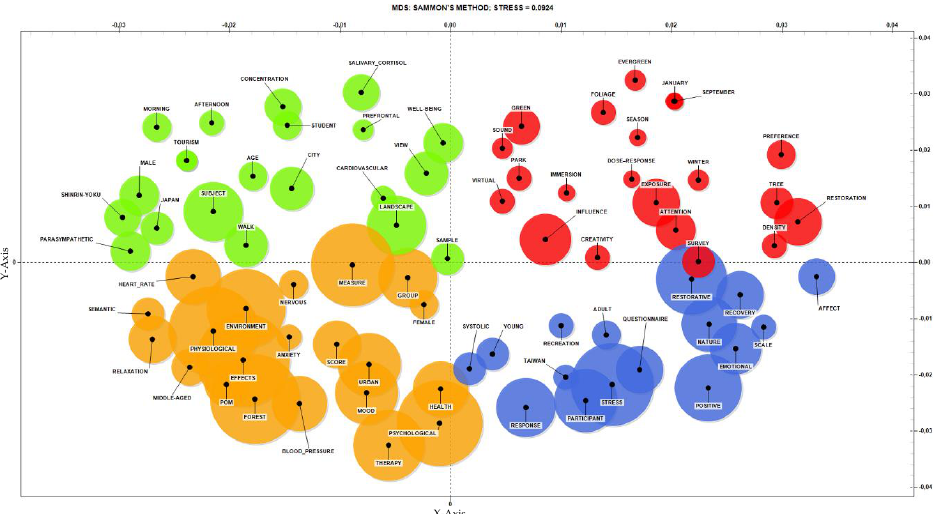
Figure 3. Sammon’s map showing relationships among lemmas (di ff erent colours denote the four